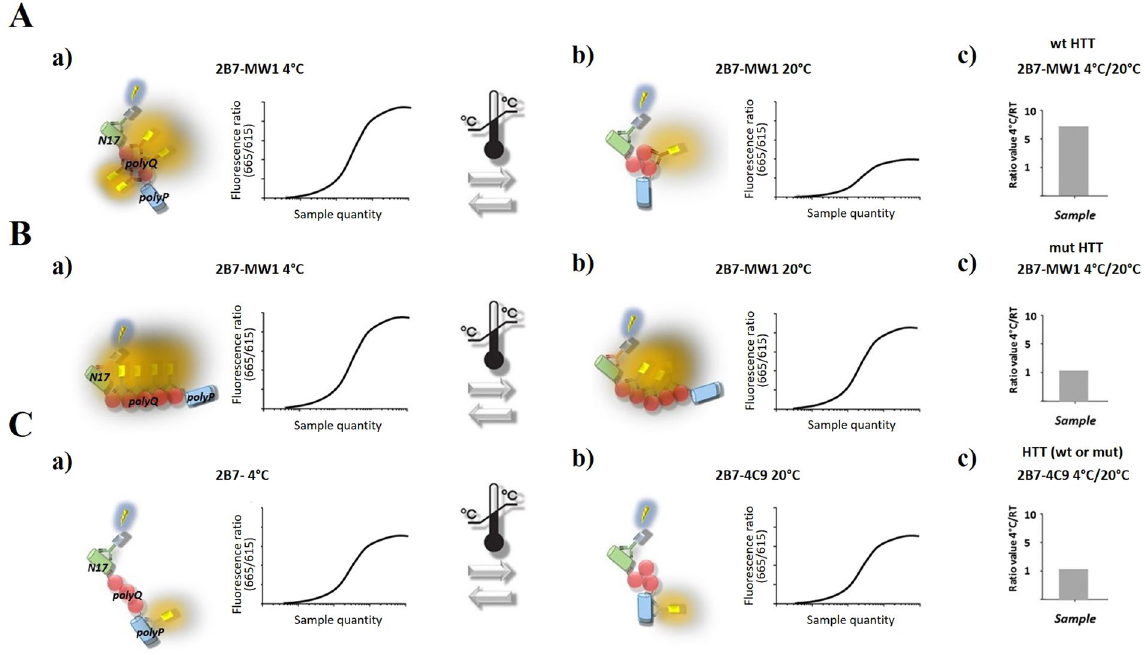
Figure 1. A schematic model illustrating the 2B7/MW1 conformational TR-FRET immunoassay for detection of HTT amino-terminal conformation (elaborated from ref. 11). The principal domains of HTT exon 1 are indicated (N17, polyQ and polyproline), together with the identity of the corresponding monoclonal antibodies used for TR-FRET detection (2B7, MW1 and 4C9, respectively). ( A ) The TR-FRET antibody pair (2B7/MW1) including one antibody targeting the polyQ domain (MW1) engages polyQ epitopes on wild type HTT differently depending on incubation temperature, as the wild type polyQ repeat is flexible and can adopt different conformations (a and b). This results in a higher ratio ( ≫ 1) between TR-FRET signals obtained from the same sample at the different temperatures (c). ( B ) The mutant polyQ repeat in mHTT is less flexible and availability/position of the polyQ epitopes for detection by the same TR-FRET antibody pair is relatively invariant at different temperatures (a and b), resulting in ratio between TR-FRET signals obtained from the same sample at the different temperatures close to 1(c). ( C ) Instead, a TR-FRET antibody pair (2B7/4C9) which does not include one antibody targeting the polyQ domain does not interrogate changes in polyQ conformation, does not significantly discern between wild type and mutant HTT and produces a ratio between TR-FRET signals obtained from the same sample at the different temperatures close to 1